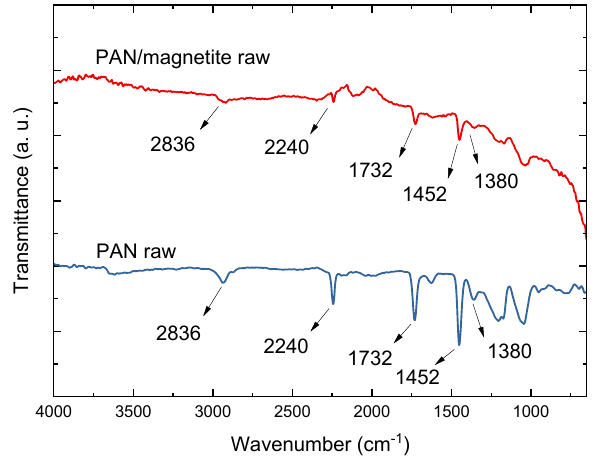
Figure 10. Fourier transform infrared (FTIR) spectra of exemplarily chosen nanofiber mats.